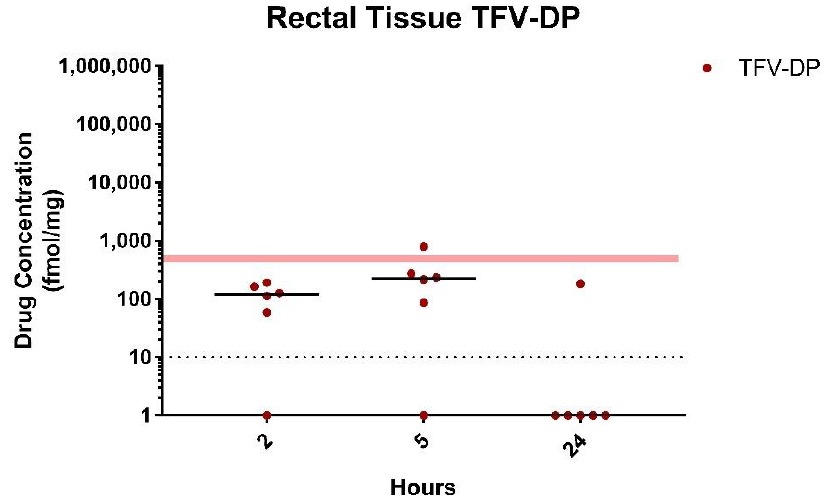
Figure 5. Intracellular TFV-DP levels following rectal administration of PEG suppositories containing TAF/EVG (8/8 mg). Dotted line denotes the lower limit of quantitation (LLOQ). Red shaded line represents levels associated with in vivo protection (82% efficacy).